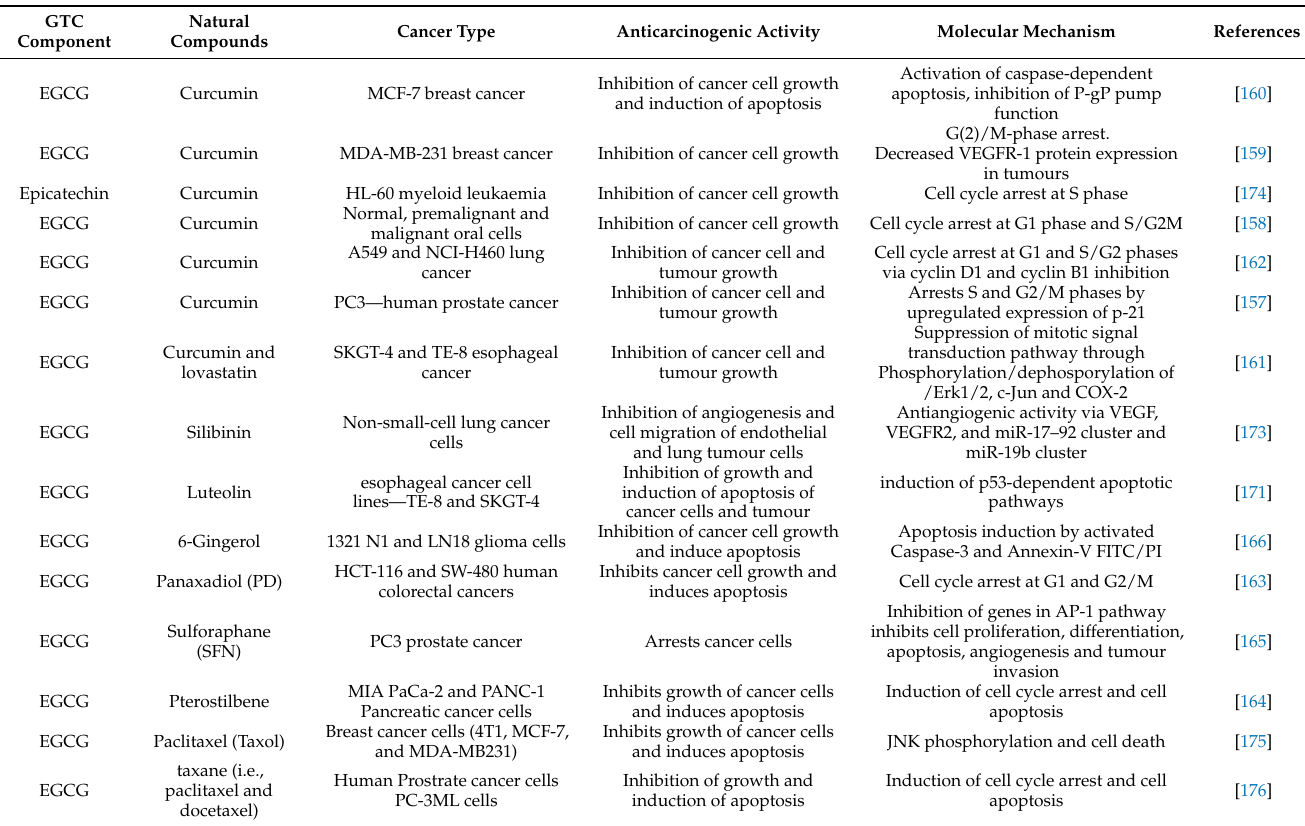
Table 1. Anticarcinogenic effects of GTCs when combined with antioxidant-rich anticancerous natural